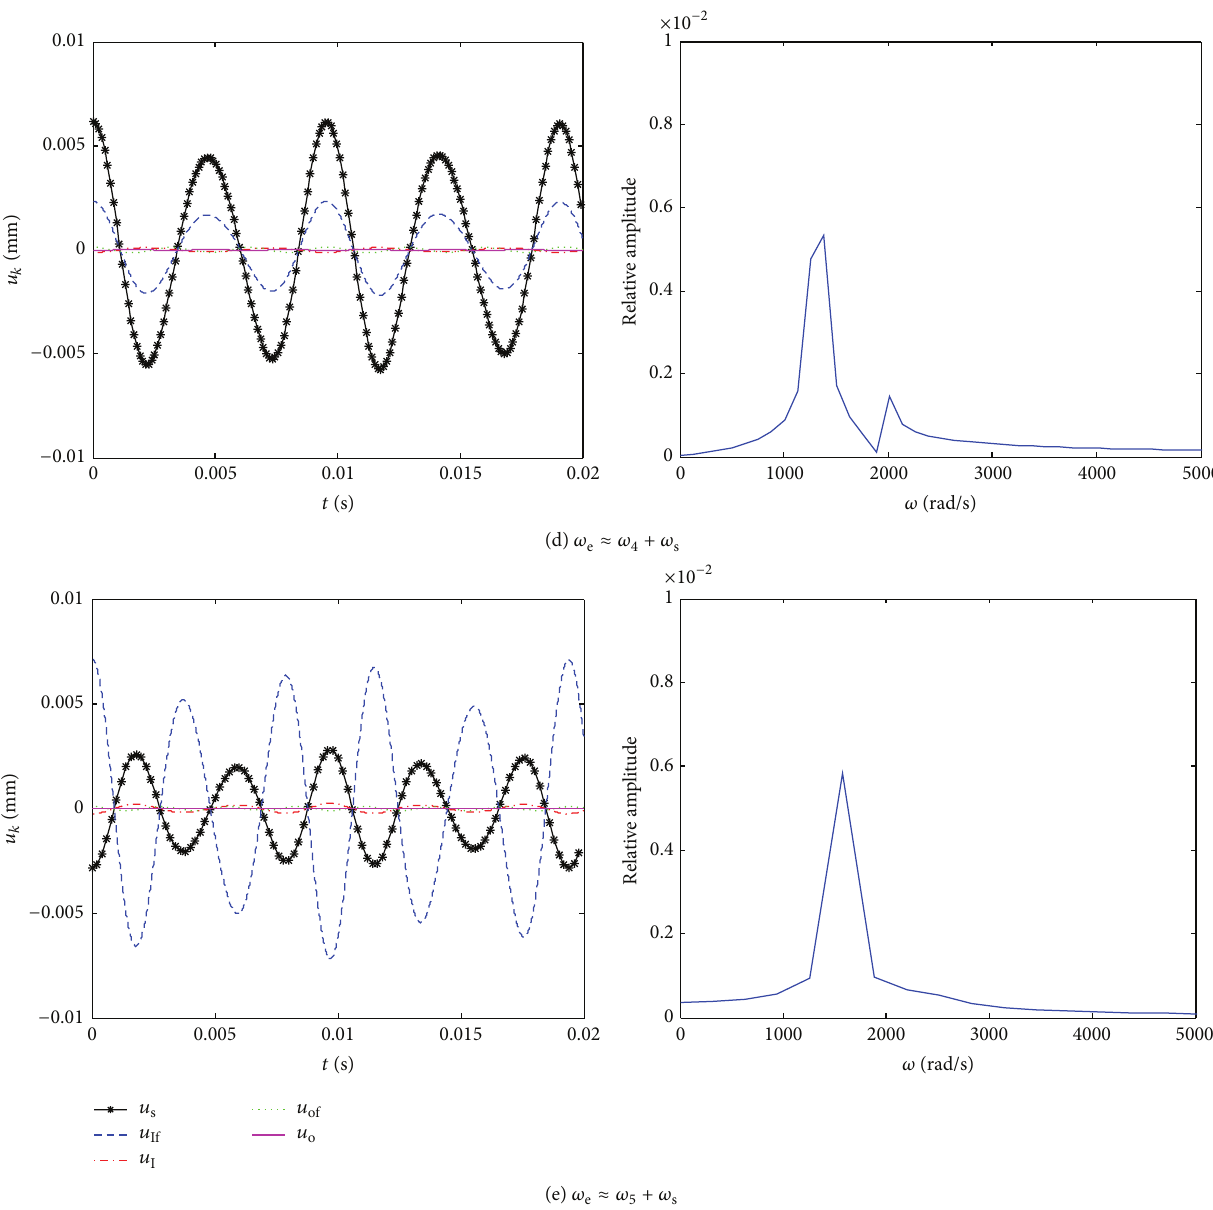
pole pairs. Considering the time-varying periodic stiffnesses, EIMG system is a typical parametric vibration